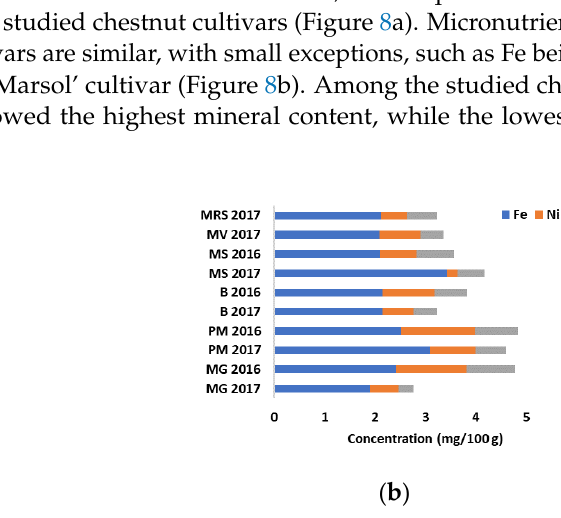
Figure 8. Mineral profile of the analyzed chestnut cultivars harvested in 2016 and 2017: ( a ) Ca, Mg, Na and K; ( b ) Fe, Ni and Cu.